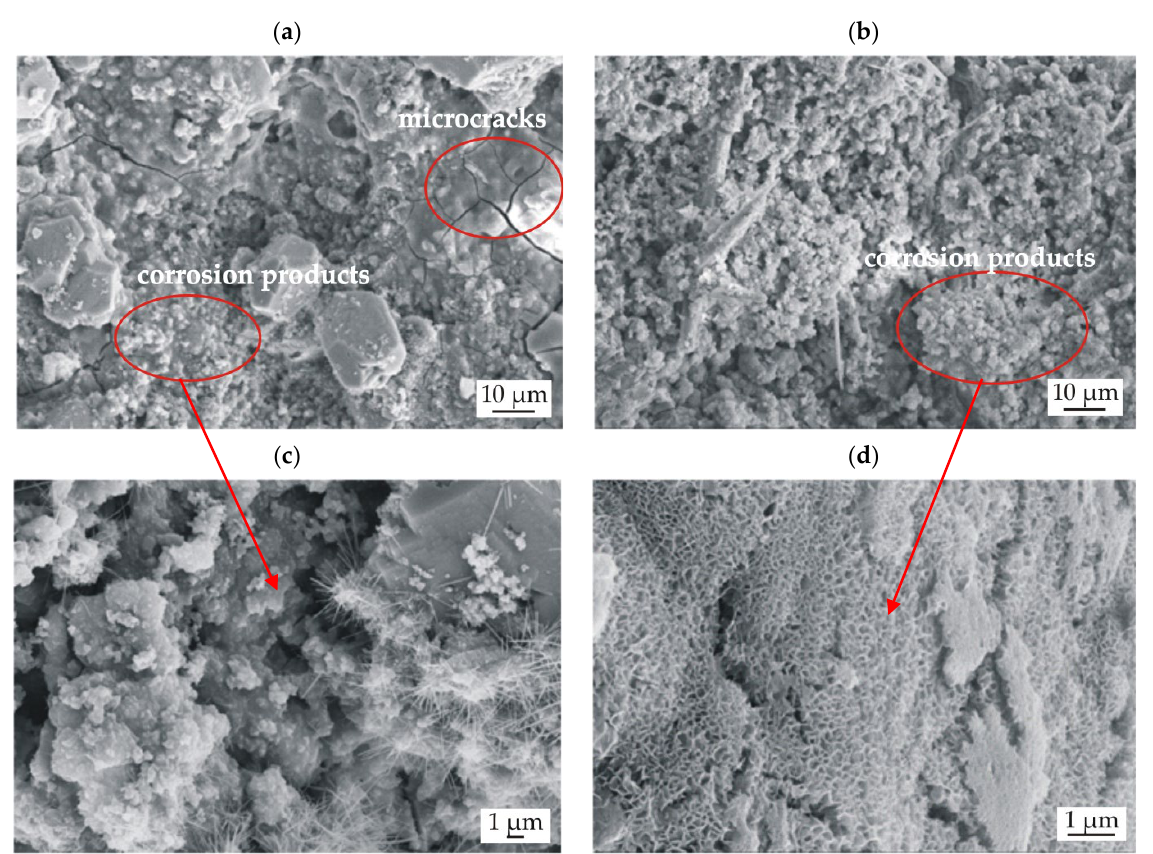
Figure 16. Sample surface with corrosion products for the casein coatings CN deposited on: ( a , c ) MgCa2Zn1 alloy; ( b , d ) MgCa2Zn1Gd3 alloy after 216 h of immersion in Ringer solution at 37 °C.